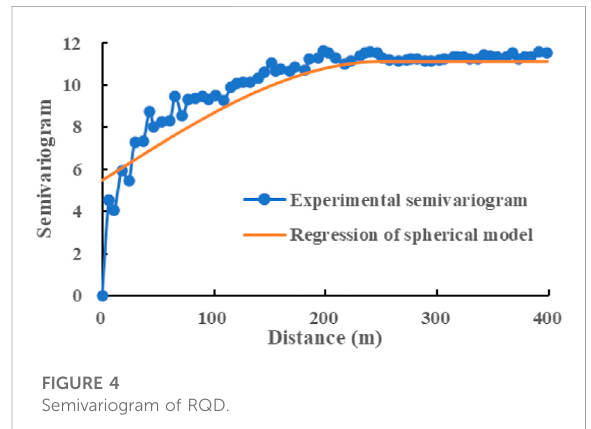
FIGURE 4 Semivariogram of RQD.